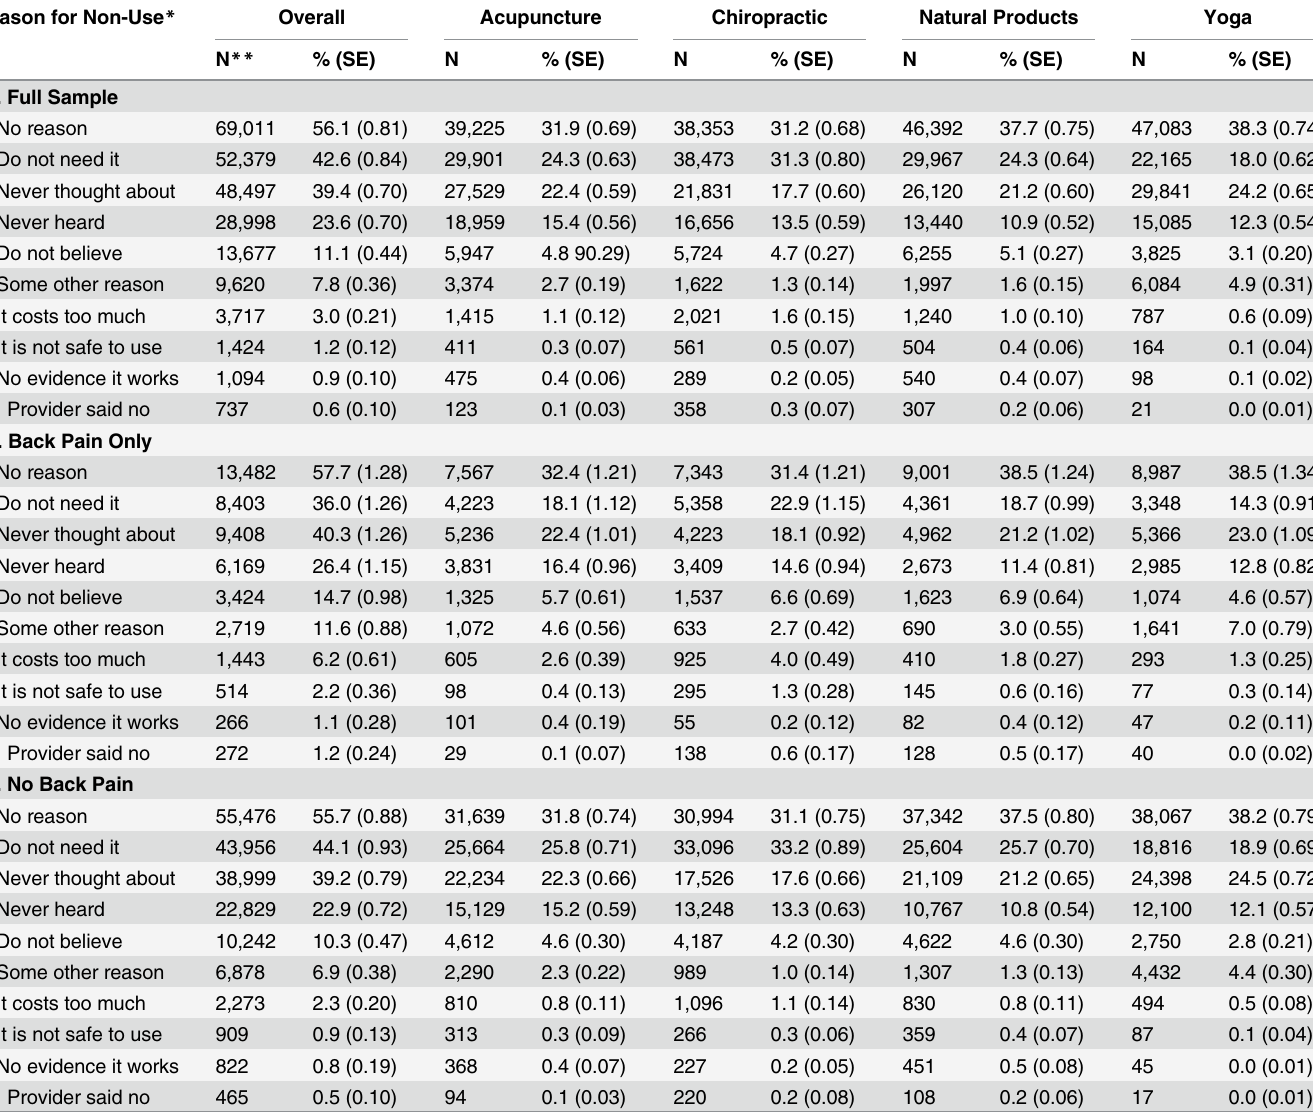
Table 1a-c. Ten reasons for non-use of four common complementary health practices by population samples analyzed. Reason for Non-Use